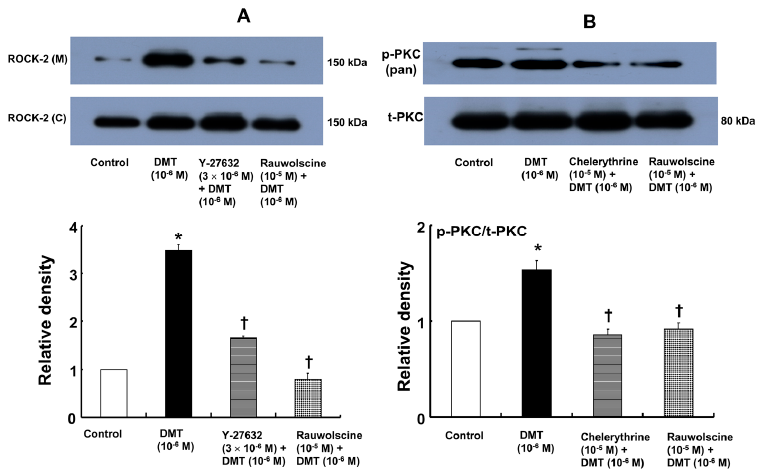
Figure 7. ( A ) Effect of Y-27632 ( n = 3) and rauwolscine ( n = 3) on the membrane translocation of Rho-kinase (ROCK-2) induced by dexmedetomidine (DMT, 10 − 6 M) in rat aortic vascular smooth muscle cells (VSMCs). VSMCs were treated with 10 − 6 M DMT alone for 10 min or with 10 − 6 M DMT for 10 min after pretreatment with 3 × 10 − 6 M Y-27632 or 10 − 5 M rauwolscine for 1 h. The translocation of ROCK-2 from the cytosol (C) to the membrane (M) was examined by western blot as described in the methods. The data are presented as the mean ± SD. N indicates the number of independent experiments. The effects of Y-27632 and rauwolscine on the membrane translocation of ROCK-2 induced by DMT were analyzed using one-way analysis of variance followed by Bonferroni’s post hoc test. * p < 0.001 versus control. † p < 0.001 versus 10 − 6 M DMT alone; ( B ) Effect of chelerythrine ( n = 4) and rauwolscine ( n = 4) on the protein kinase C (PKC) pan-phosphorylation induced by DMT (10 − 6 M) in rat aortic VSMCs. VSMCs were treated with 10 − 6 M DMT alone for 4 min or 10 − 6 M DMT for 4 min after pretreatment with 10 − 5 M chelerythrine or 10 − 5 M rauwolscine for 1 h. The data are presented as the mean ± SD. N indicates the number of independent experiments. The effects of chelerythrine and rauwolscine on the PKC pan-phosphorylation induced by DMT were analyzed using one-way analysis of variance followed by Bonferroni’s post hoc test. * p < 0.001 versus control. † p < 0.001 versus 10 − 6 M DMT alone. p-PKC (pan): phosphorylated PKC (pan), t-PKC: total PKC.